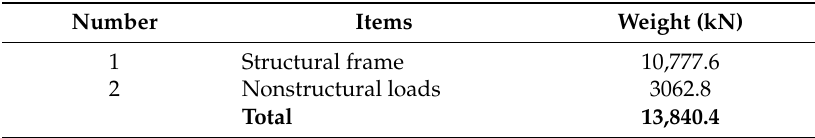
Table 2. Total weight of Korean container crane used in this